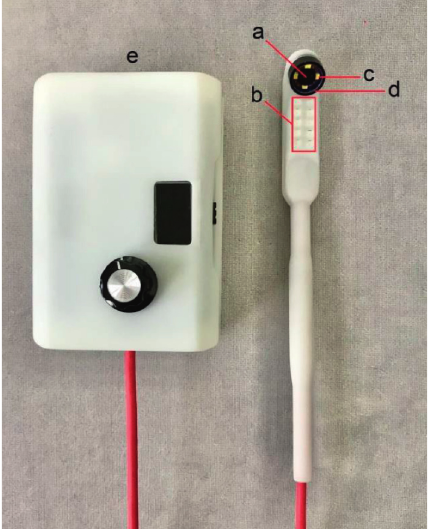
Figure 2: The intraoral camera with fluorescent aids for the screening of OPMDs used in teledentistry. This device consists of (a) camera image sensor and lens, (b) UV-blue light source, (c) white light source, (d) light filter, and (e) controller and processing units with rechargeable battery.